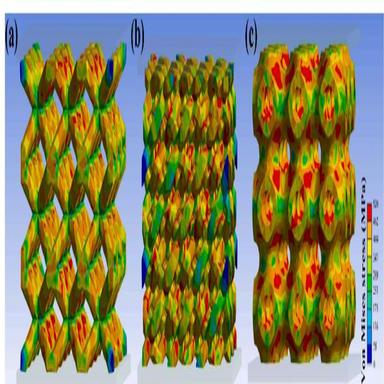
Von Mises stress distribution for (a) BCC, (b) Diamond, and (c) Schwarz lattice structures at 7 % compressive strain.